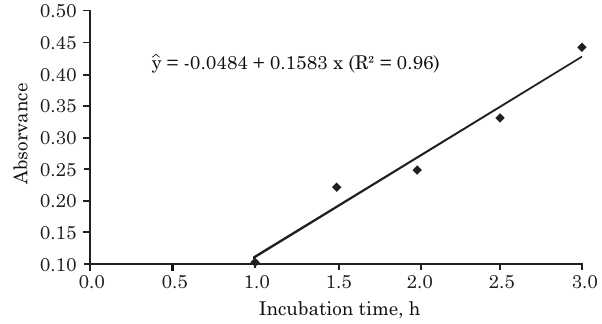
Figure 2. Absorbance (at 636 nm) due to NH 3 production (mediated by urease activity) in lettuce-leaf extracts as a function of the reaction periods (incubation time, IT) for NH 3 production at 40 °C.